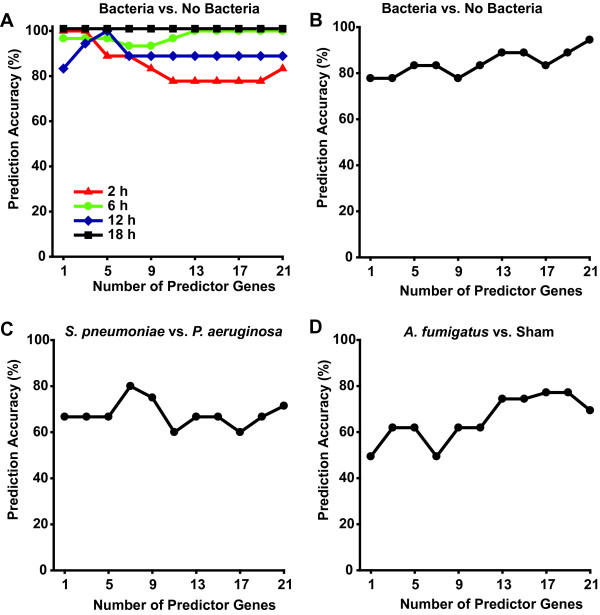
Diagnostic accuracy of computerized gene expression interrogation. Mice were exposed to one of four potential infectious conditions, then gene expression profiling was performed at designated time points after the challenge. (A) Diagnostic accuracy of algorithmic predictions of whether or not different mice were infected with bacteria, based on the time after infection and the number of transcripts used in the prediction model. (B-D) Rules derived from initial 18 h experiments were used to predict the infectious conditions of different mice 18 h after challenge in a separate validation set, based on number of transcripts in the algorithm. (B) Prediction accuracy for discriminating bacteria vs. non-bacteria. (C) Prediction accuracy for discriminating S. pneumoniae infection from P. aeruginosa infection. (D) Prediction accuracy for discriminating A. fumigatus from sham infection.